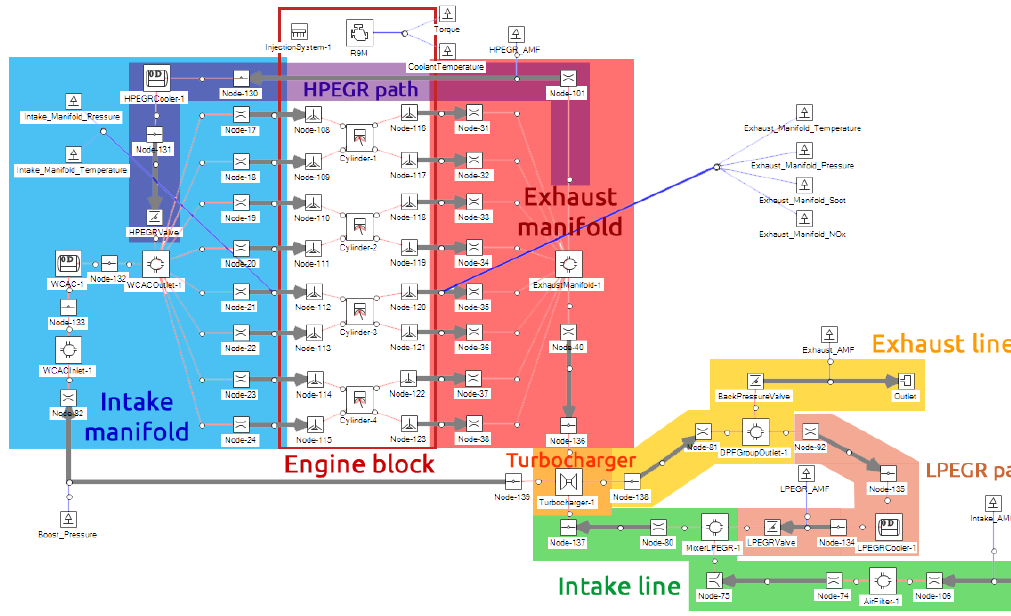
Figure 3. Model scheme of the 1D engine model in VEMOD